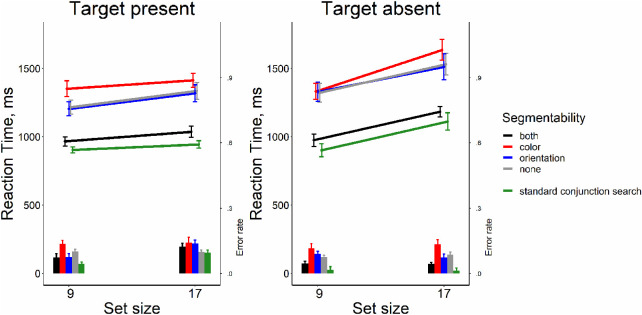
Reaction time and error rate as a function of set size and segmentability in Experiment 3. Error bars denote the SEM, with between-subject variance removed in accordance with the Cousineau (2005) method.